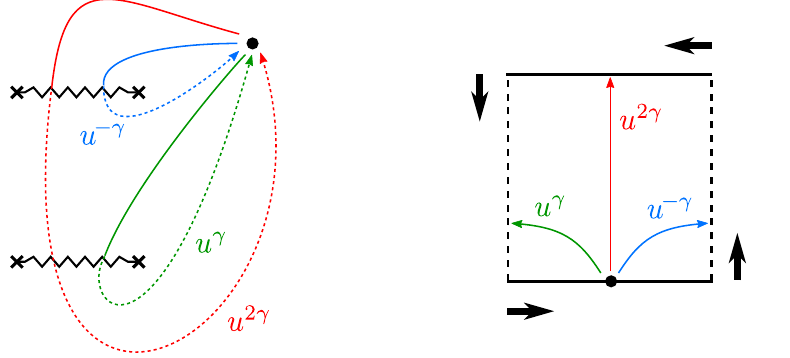
Figure 21 . The crossing and the mirror transformations. The left (cid:12)gure shows the analytic continuation in the rapidity plane while the right (cid:12)gure shows the spacetime interpretation of each manipulation. In the left (cid:12)gure, the upper branch cut comes from x (cid:0) while the lower branch cut comes from x + . In the right (cid:12)gure, we also indicated the direction of space coordinates in each channel by thick black